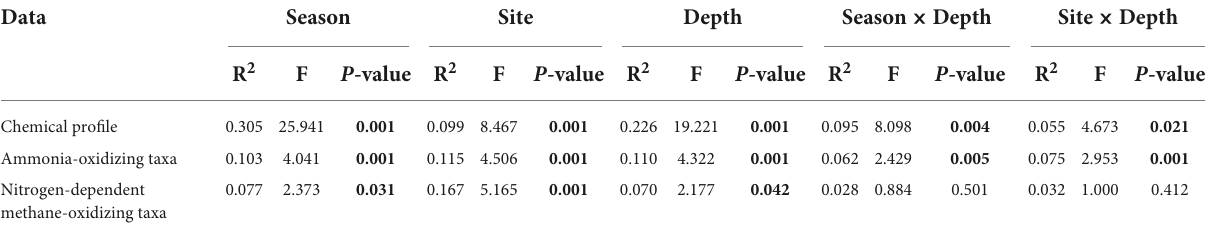
TABLE 2 Permutational multivariate analysis of variance of the chemical properties and the microbial community profiles in the floodplain of the Tocantins River.